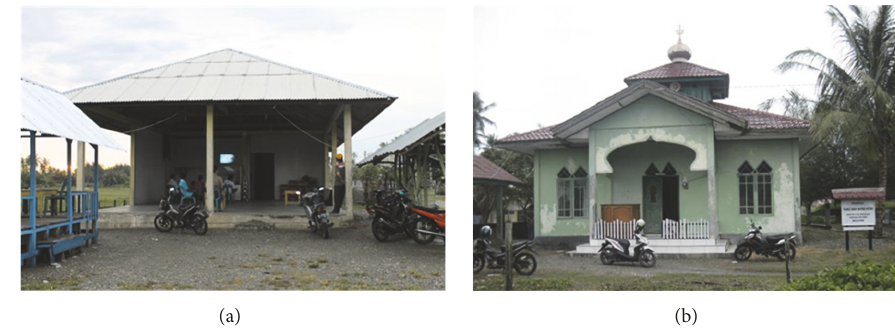
Figure 6: New buildings: (a) Objects III and (b) Object IV.